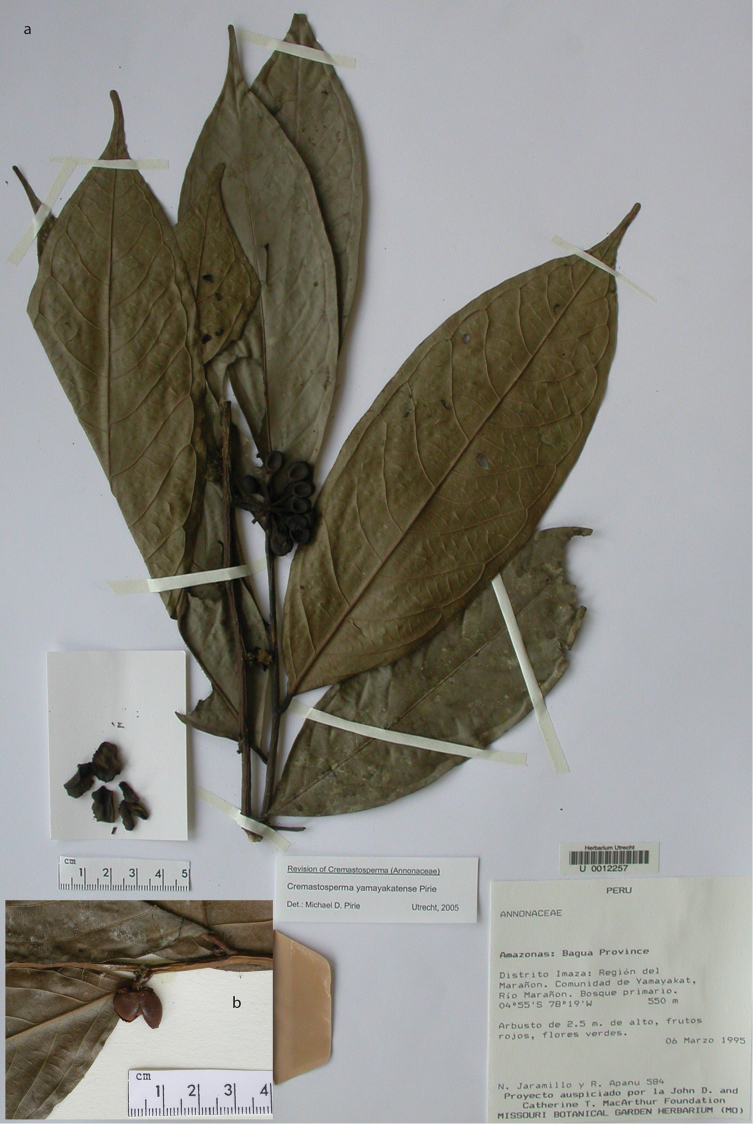
Cremastospermayamayakatense Pirie. a fruiting specimen b flower (a Jaramillo & Apanu 584 b Barbour 4432).